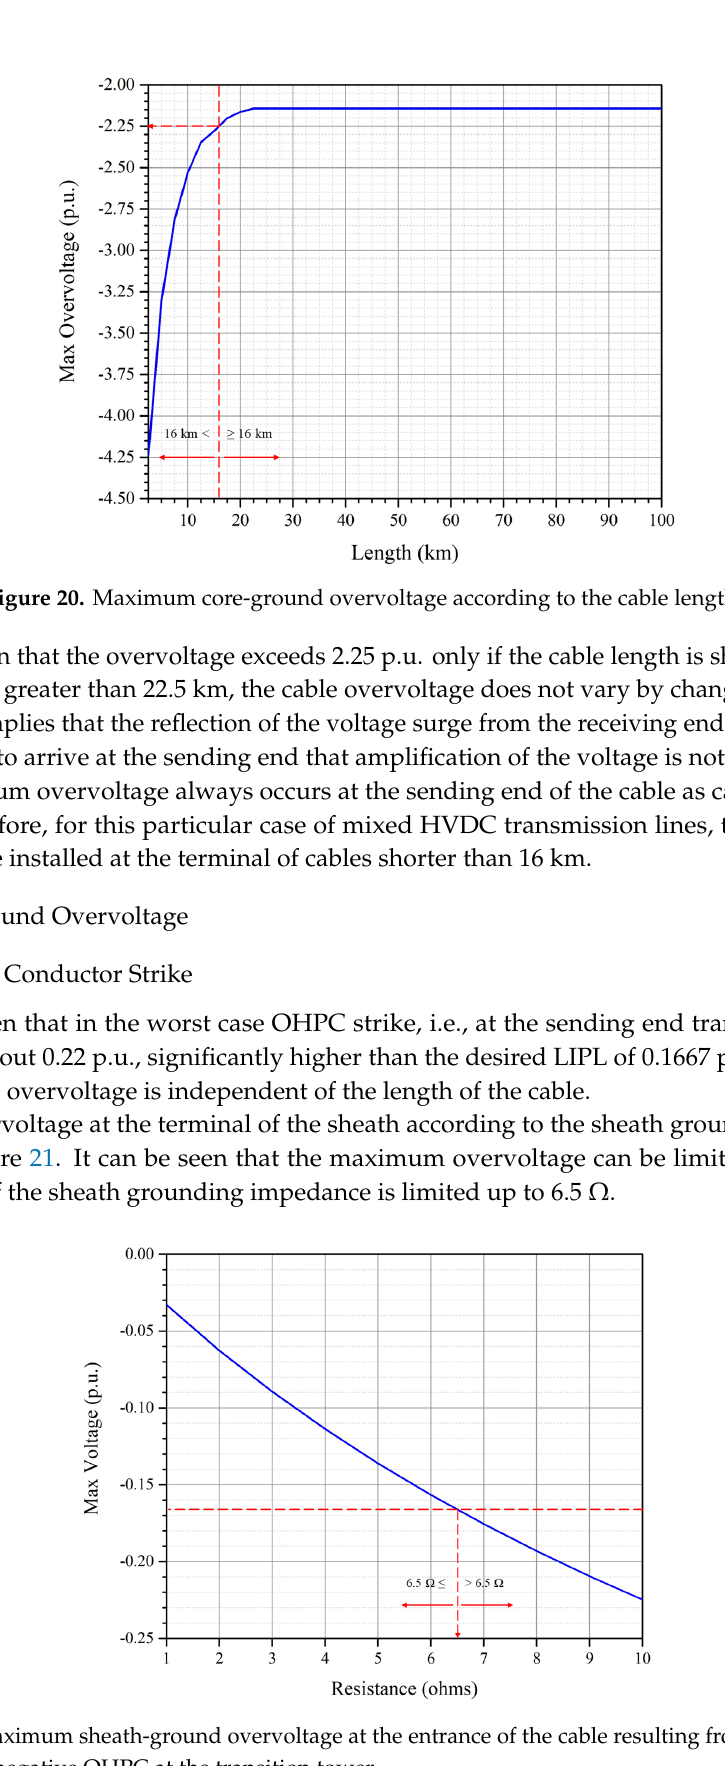
Figure 21. Maximum sheath-ground overvoltage at the entrance of the cable resulting from a lightning strike on the negative OHPC at the transition